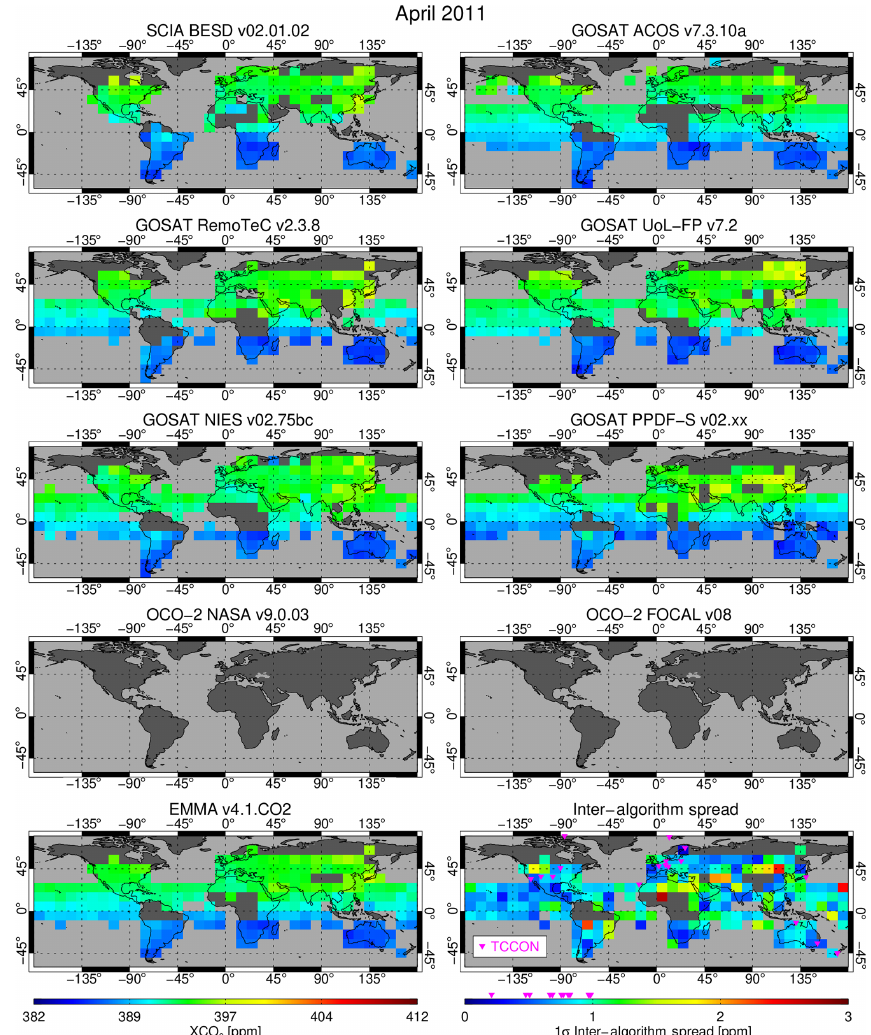
Figure 9. April 2011 XCO 2 at 10 ◦ × 10 ◦ spatial resolution showing (i) the individual sensor/algorithm input data sets (panels in rows 1–4; see Table 1 for details), (ii) EMMA XCO 2 (bottom left), and (iii) the inter-algorithm spread (IAS, 1 σ ) as computed by EMMA (bottom right; see main text for details). Also shown in the bottom-right panel are the locations of the TCCON sites (pink triangles) and the range of IAS values covered by them (see color bar). Note that the OCO-2 maps (row 4) are empty because this satellite was launched after April 2011 (see Fig. 10 for OCO-2 XCO 2